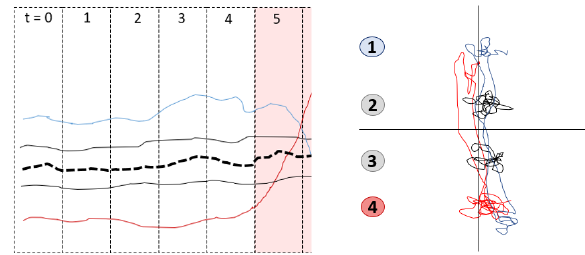
Figure 2. The objects’ movements are transformed to relative movements. Left: a mean group trajectory is calculated (dashed black line). Right: the resulting relative trajectories.